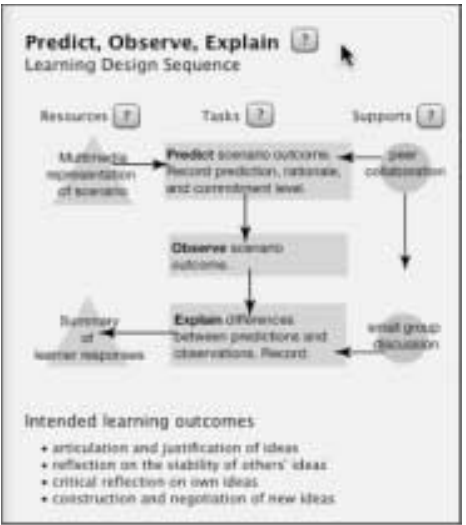
Figure 4. POE Learning